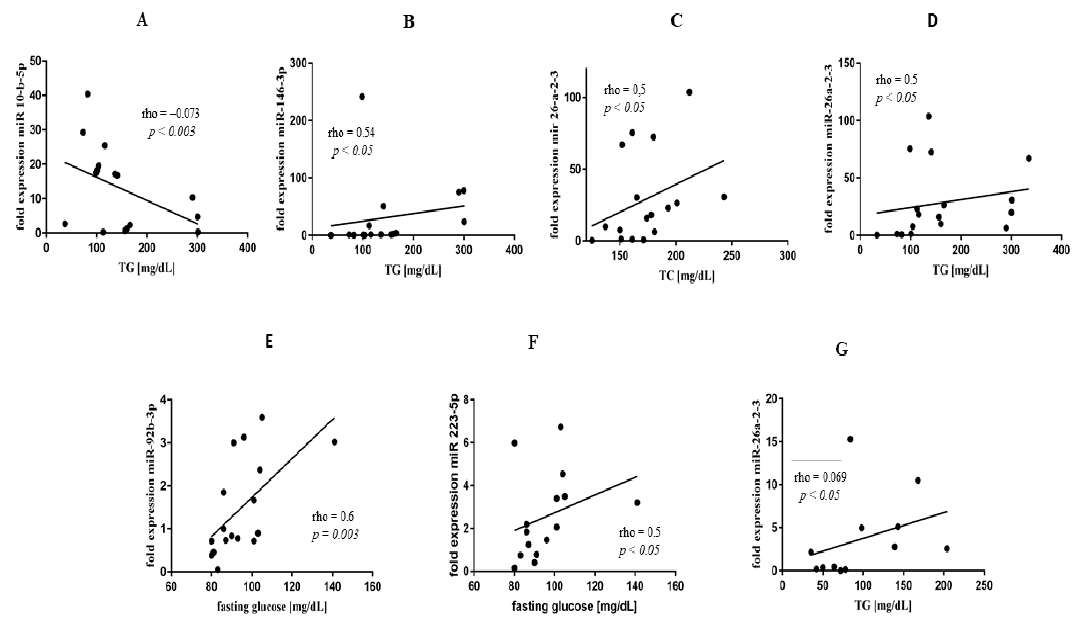
Figure 4. Correlation analyses of miR expression, TG, and glucose concentration in PsA ( A – E ) and RA ( F , G ) groups of patients.